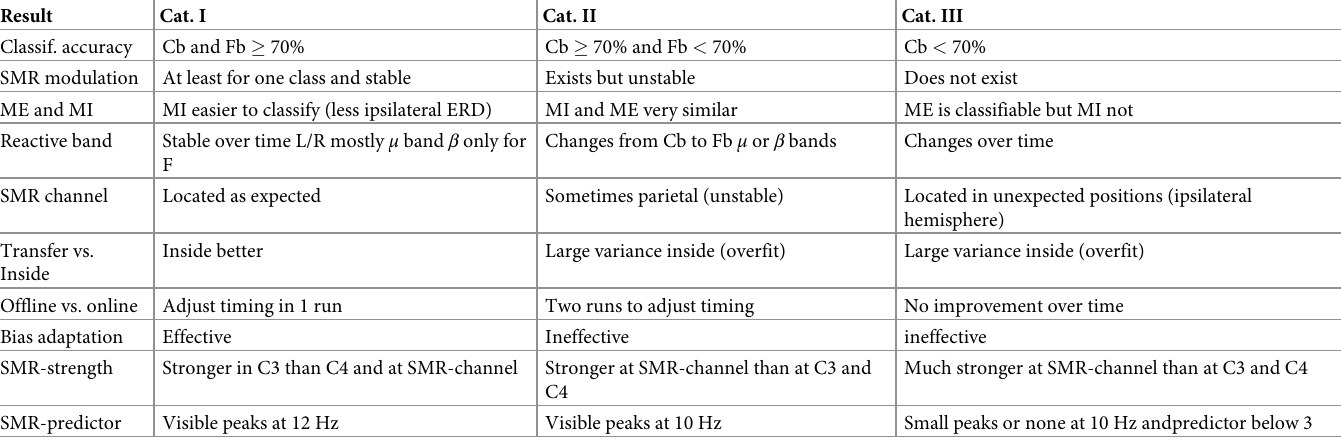
Table 5. Summary of results according to